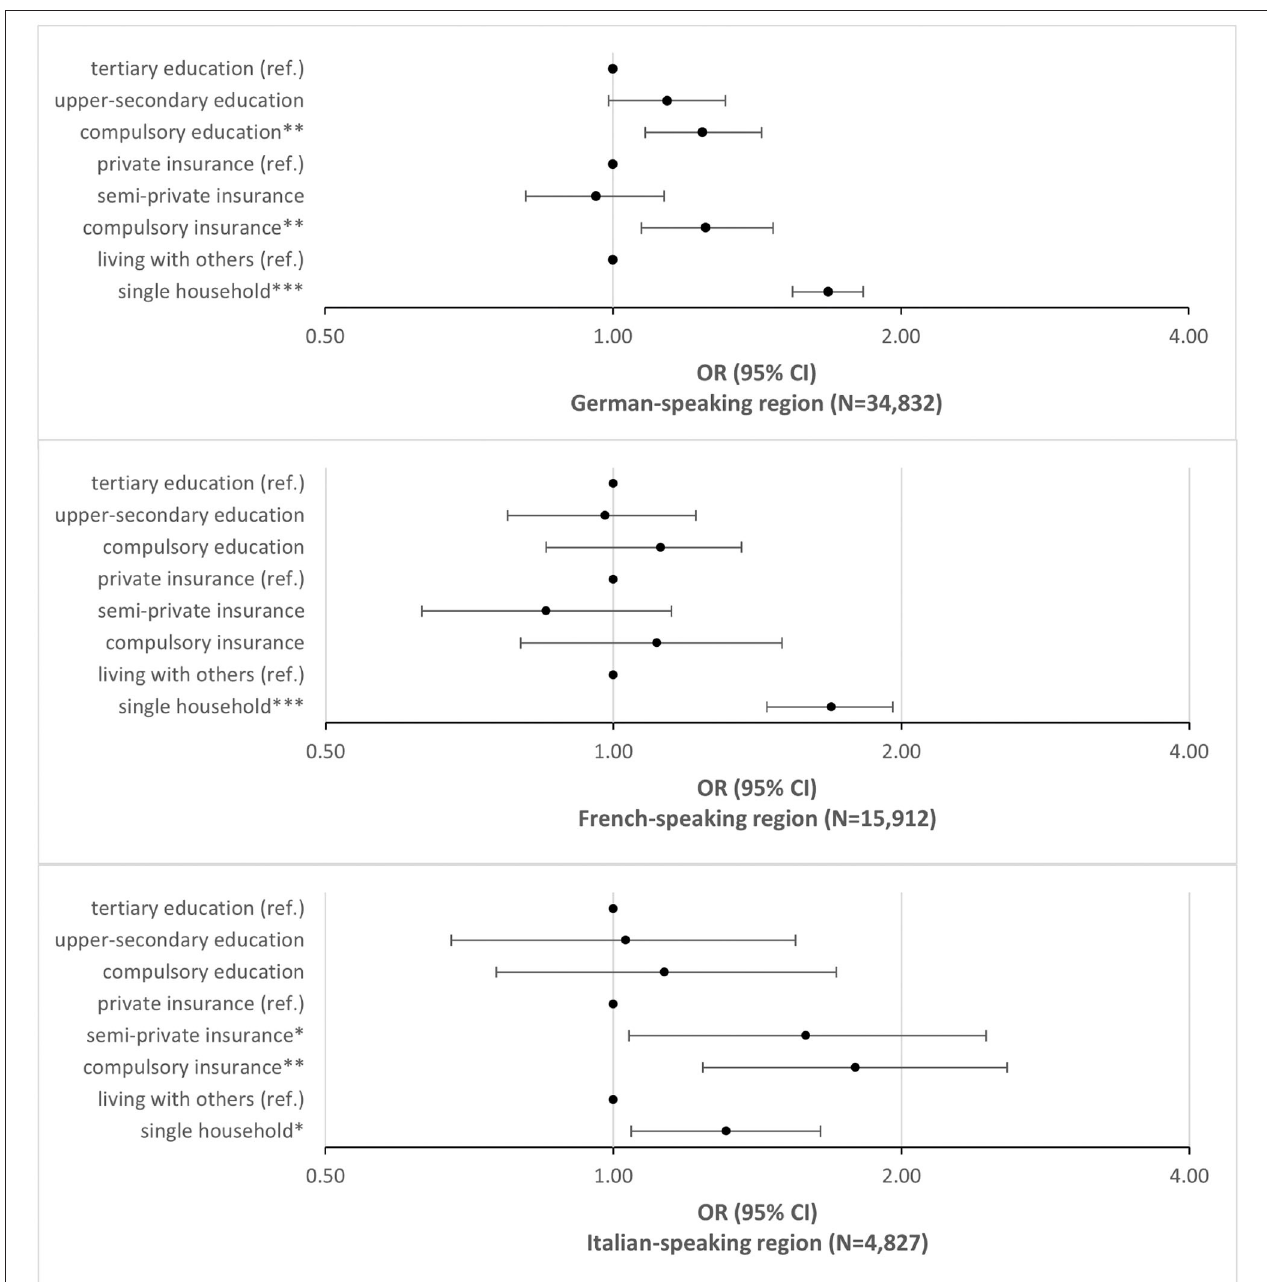
FIGURE 3 | Social determinants and nursing home admissions in the language regions. Odds of admission to a nursing home after hospital discharge; logistic regression model B stratified for the three language regions in Switzerland controlled for gender, age group, nationality, health status and year of hospital admission: OR, CI 95%, * p < 0.05; ** p < 0.01; *** p <